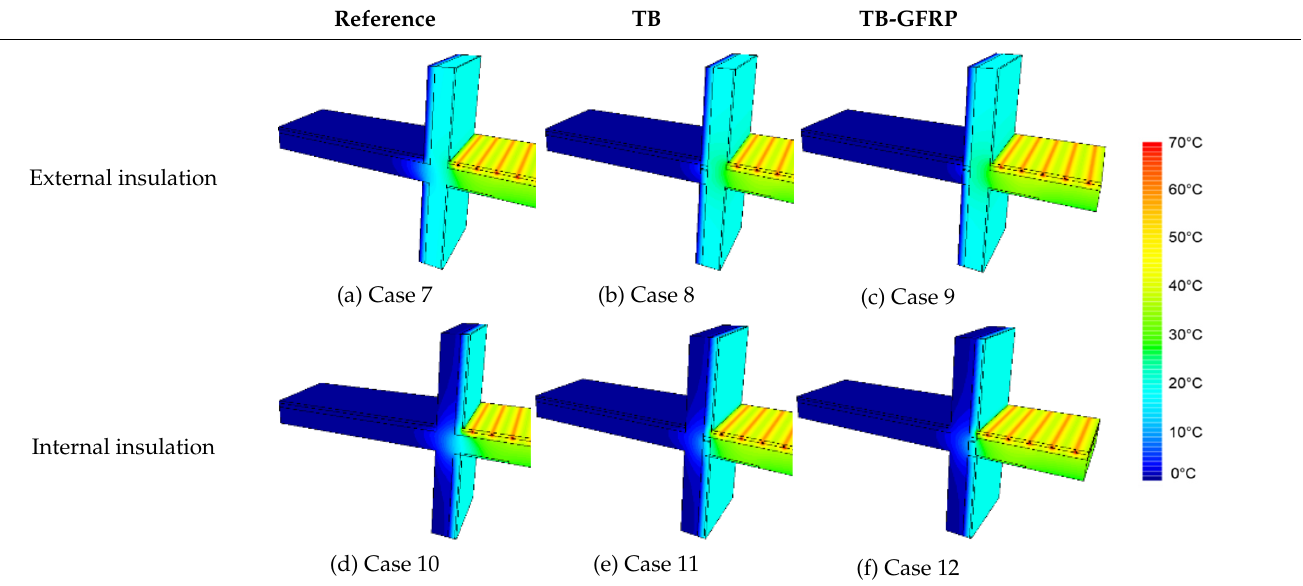
Table 6. Simulation results of heat transfer under radiant floor heating condition.